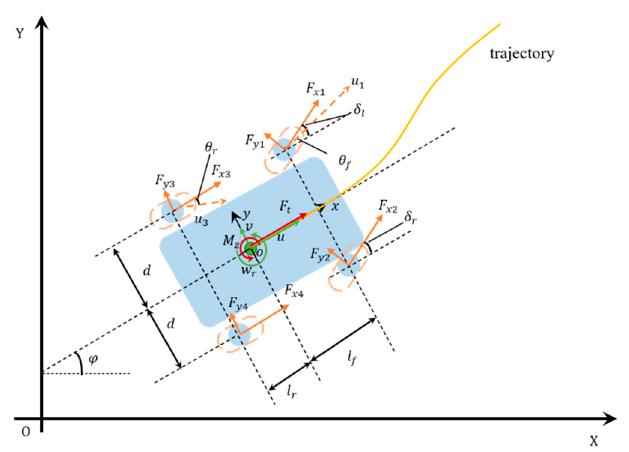
Figure 1. The two-track model with a reference position trajectory.